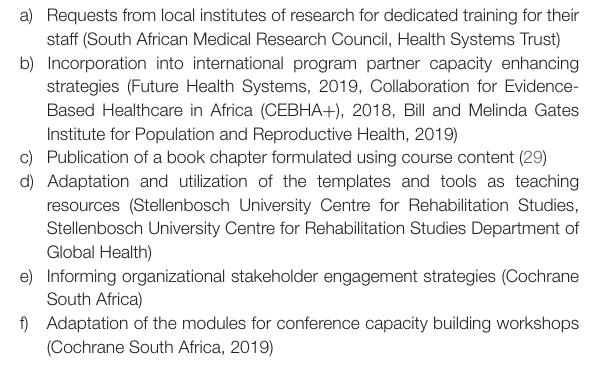
Figure 2 indicates participant appraisal of facilitation and content of the